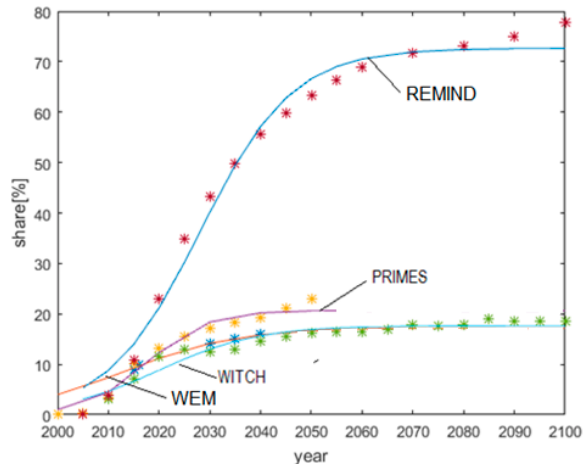
Figure 11. Reference scenarios for WEM, WITCH, PRIMES and REMIND programs for Europe’s solar PV capacity share (own work). Energies 2019 , 12 , x FOR PEER REVIEW